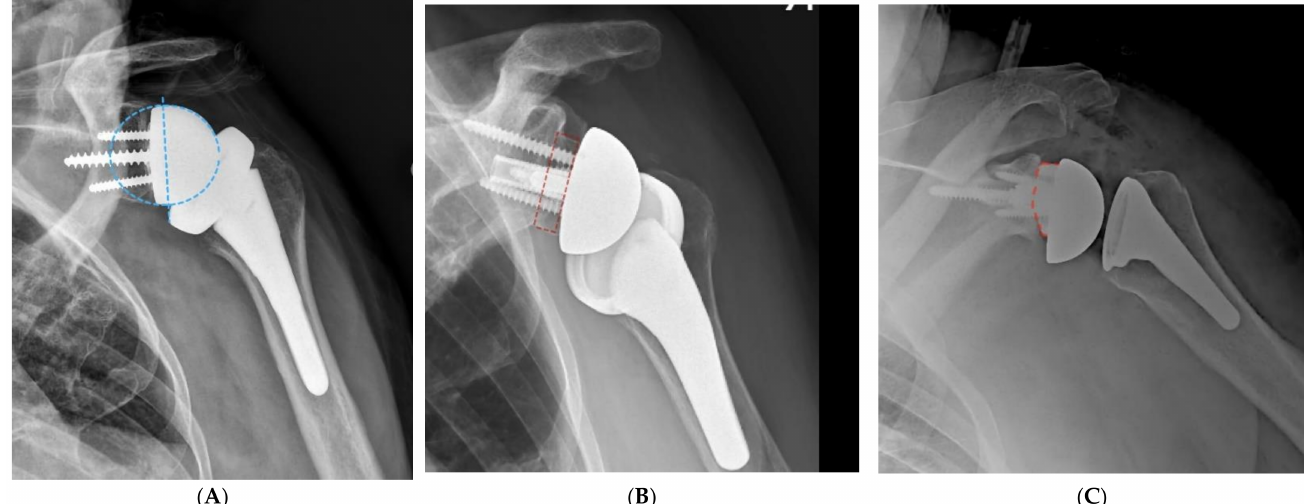
Figure 4. ( A ), Impingement-free range of motion is optimized with implantation of larger glenospheres with a lateral offset and an inferior overhang. Glenoid lateralization may be achieved with thicker glenospheres ( B ), the use of a bone graft under the baseplate (BIO-RSA), or the use of augmented baseplates ( C